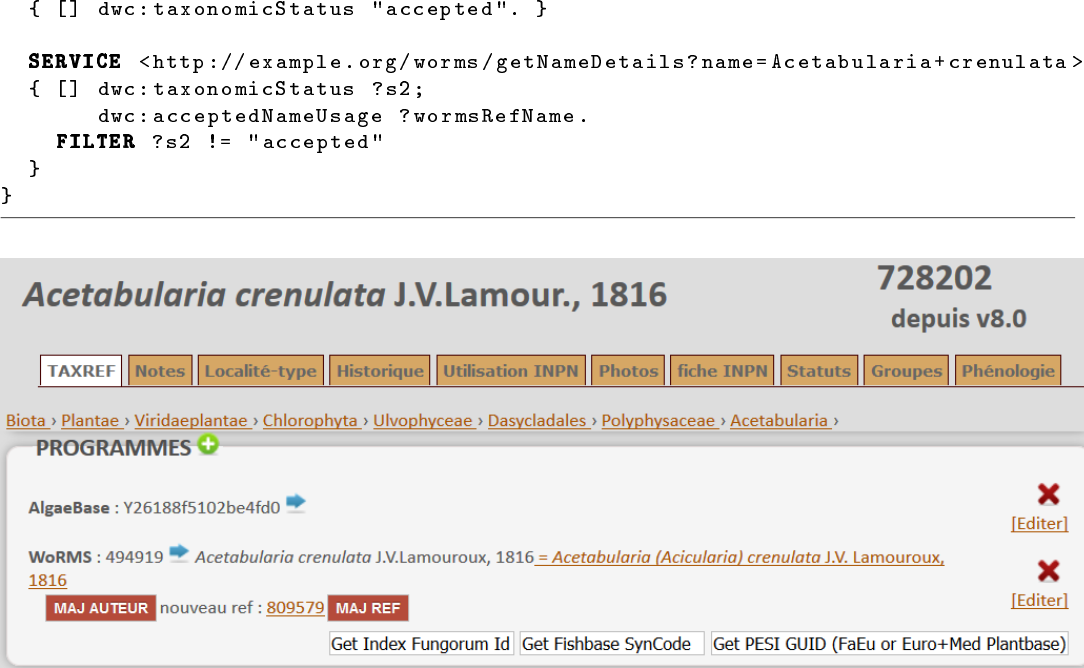
Figure 8. TAXREF-Web suggestions for editing taxon Acetabularia crenulata .